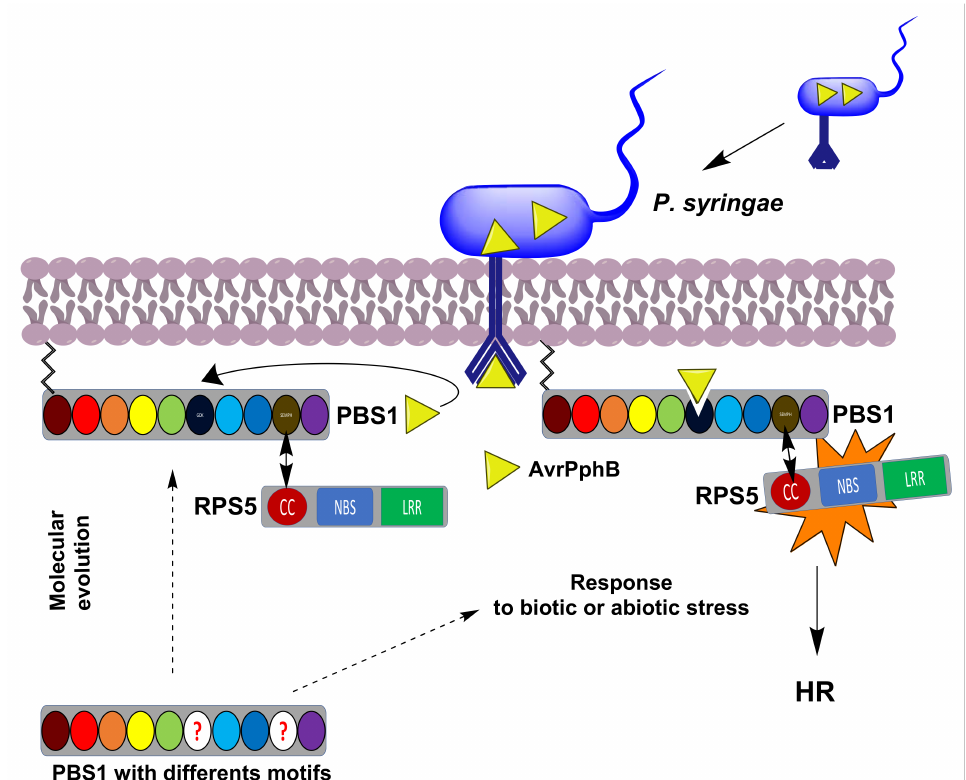
Figure 1. Schematic representation of the P. syringae AvrPphB effector activation of RPS5 mediated by PBS1 leading to the defense response. PBS1 is normally associated, through its SEMPH motif, to the RPS5 CC domain, forming a complex in which the latter is inactive. Afterwards, the AvrPphB effector (yellow triangle), injected by P. syringae , binds and cleaves PBS1 in its GDK motif. This induces a conformational change in RPS5, thus activating the HR. The evolutionary origin of the GDK and SEMPH motifs in Arabidopsis and other plants is not clear. A role for the PBS1-RPS5 system in activation of the defense response in other plant lineages is unknown. The circles correspond to the PBS1 motifs and kinase subdomains (GxGxxG, burgundy; K, red; E, orange; DxxxSN, yellow; DFG, green; GDK motif, dark blue; APE, light blue; DxxxG, blue; SEMPH motif; dark yellow; and R, purple). The circle with red questions indicates different motifs. Dotted arrows indicates a possible to the classic PBS1-RPS5 system or a possible response to abiotic or biotic stress. An arrow indicates interaction between the SEMPH and CC